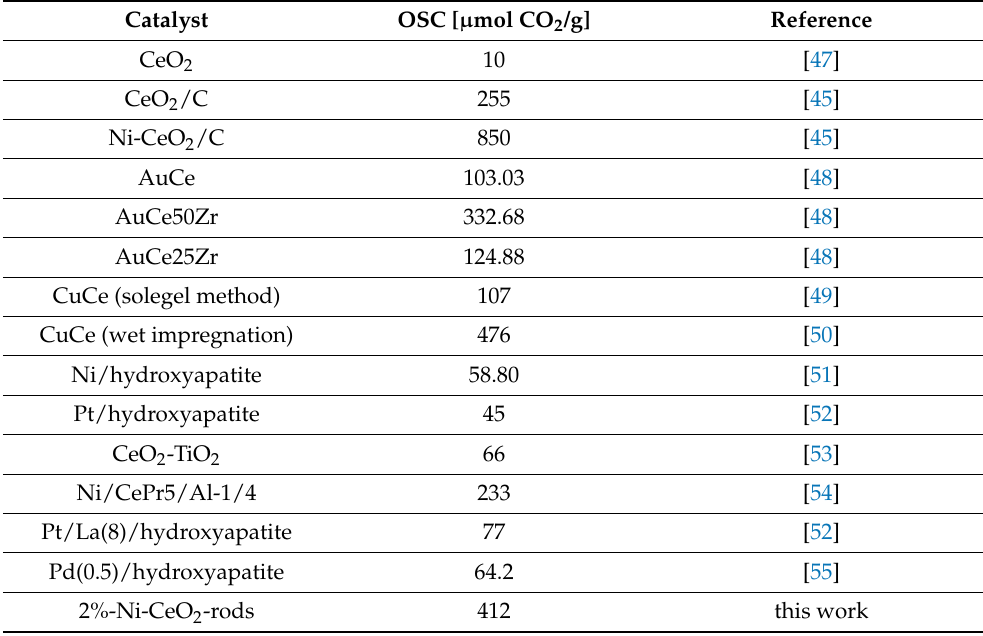
Table 6. Oxygen storage capacity (OSC) in µ mol CO 2 /g sample for the different